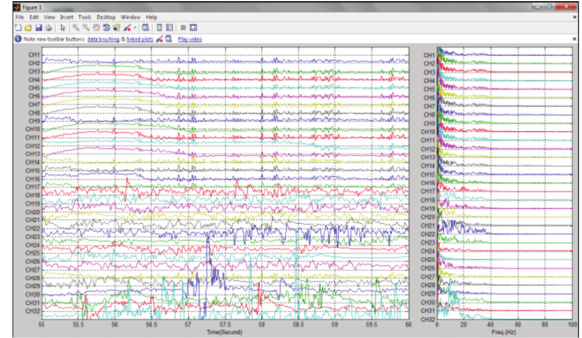
Figure 15: EEG system